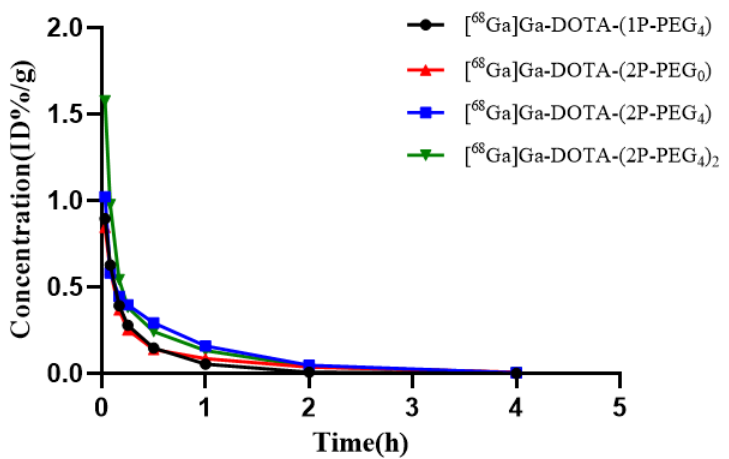
Figure 4. The relation curve between average plasma concentrations of 68 Ga-labeled compounds and time.